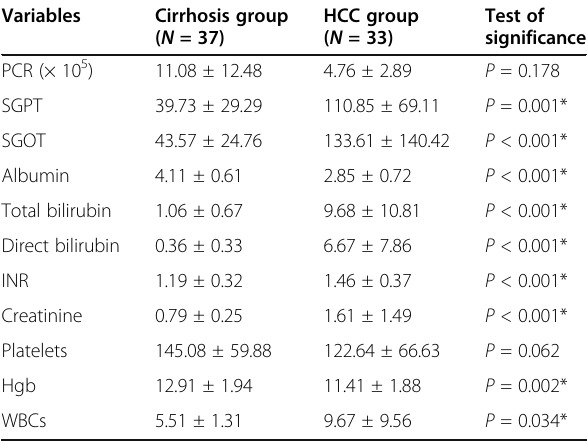
Table 2 Comparison of laboratory findings in cirrhosis and HCC groups